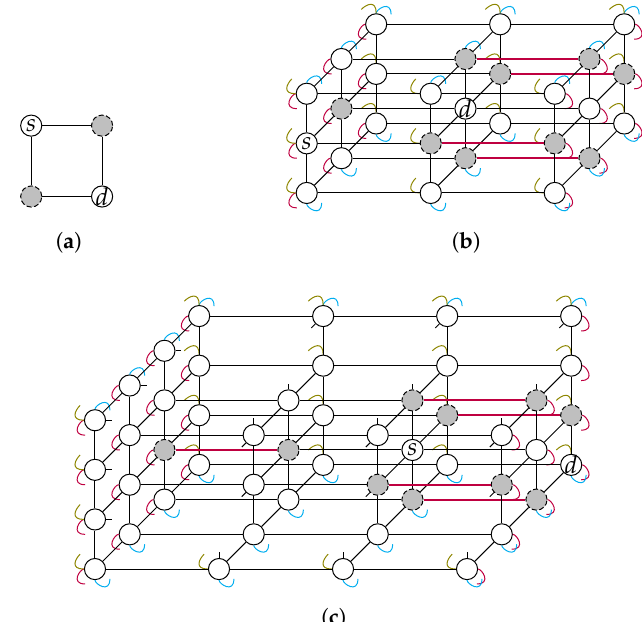
Figure 4. Unsolvable problem instances in the case k = 2 ( a ), k = 3 ( b ) and k = 4 ( c ), within a T ( 2,2 ) with two clusters, a T ( 3,3 ) with five clusters and a T ( 3,4 ) (some nodes are omitted for clarity) with five clusters, respectively. Faulty nodes are greyed and the clusters that include two nodes are materialised with thicker